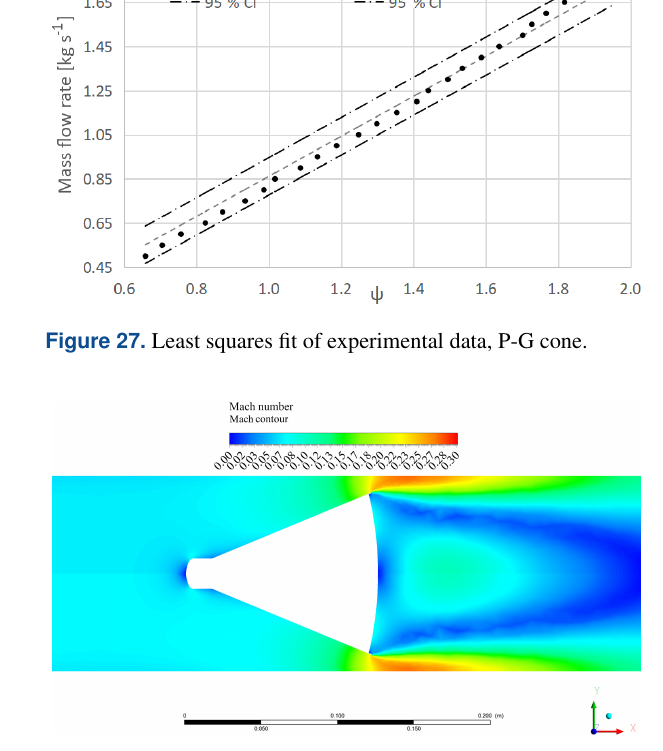
Figure 28. Mach number contour map, S-G V-Cone, β ≈ 0 . 620.